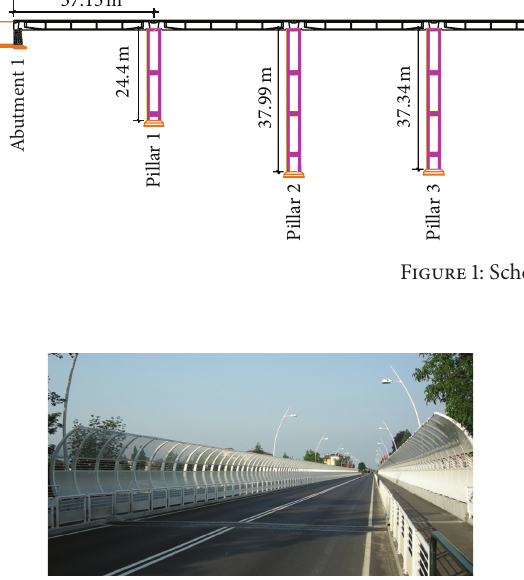
Figure 2: Deck of “Ponte degli Alpini.”